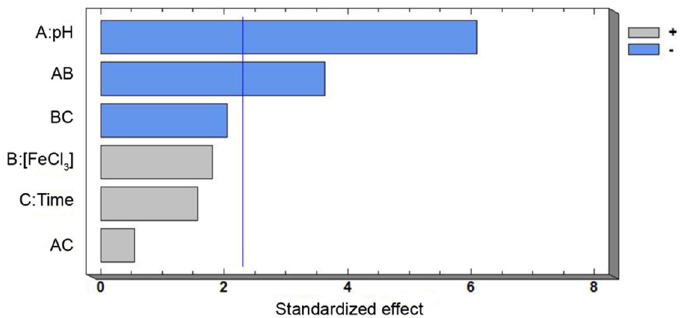
Figure 3. Pareto diagram of coagulation / sedimentation experiments with FeCl 3 · 6H 2 O coagulant.